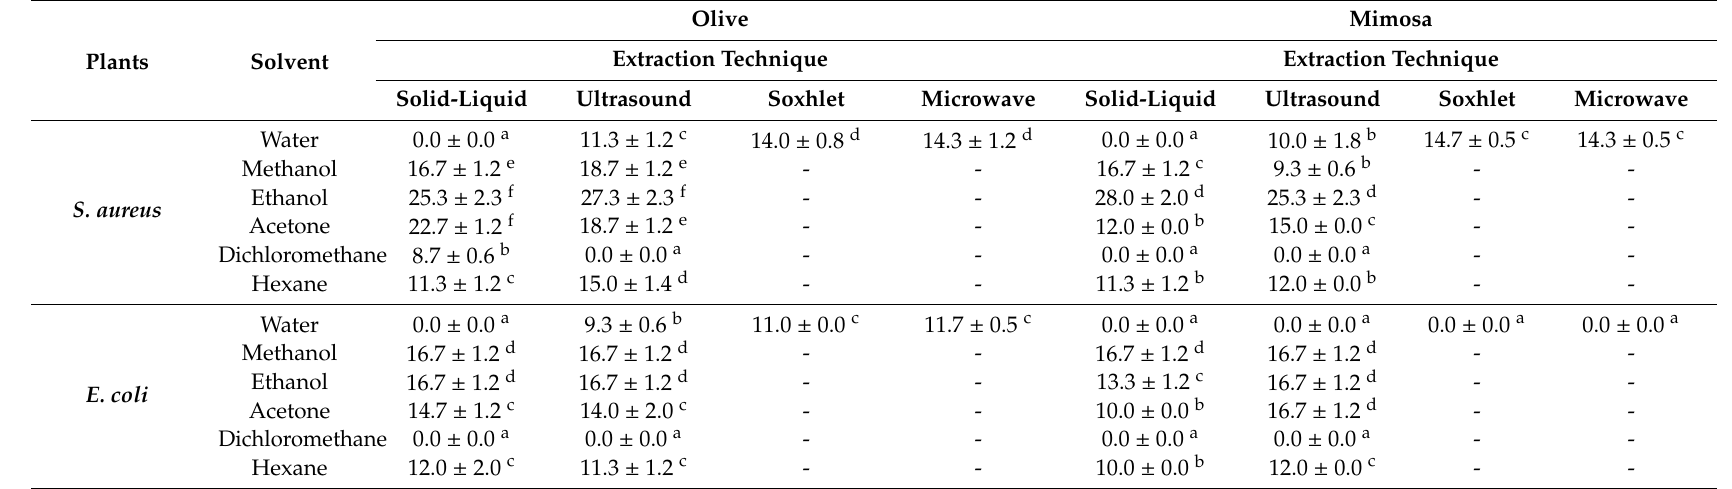
Table 2. Antibacterial activity of olive and mimosa leaf crude extracts at di ff erent concentrations obtained with the di ff erent extraction techniques and the selected solvents against Staphylococcus aureus and Escherichia coli (expressed in diameter of inhibition zone